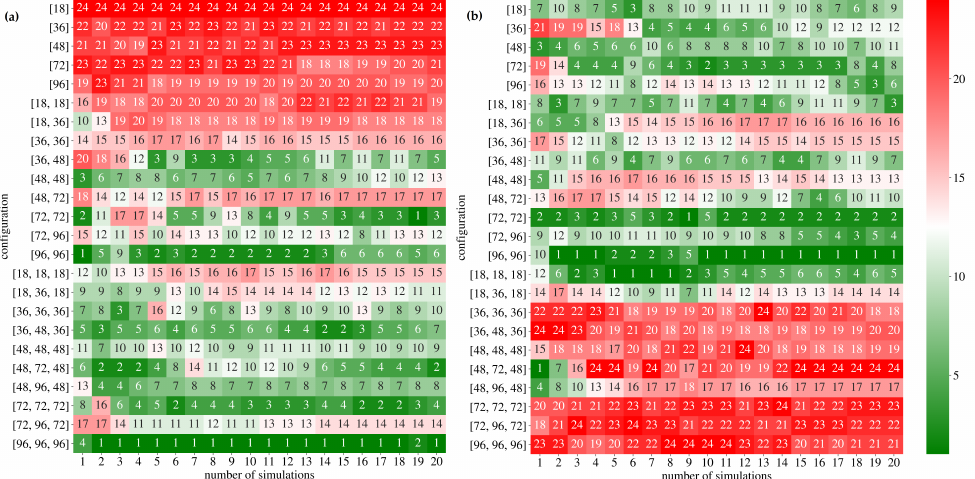
Figure 6. Heatmap of the medians rank for each configuration in the case of 24 h horizon. Panel ( a ) shows the FFNN models and Panel ( b ) the LSTM